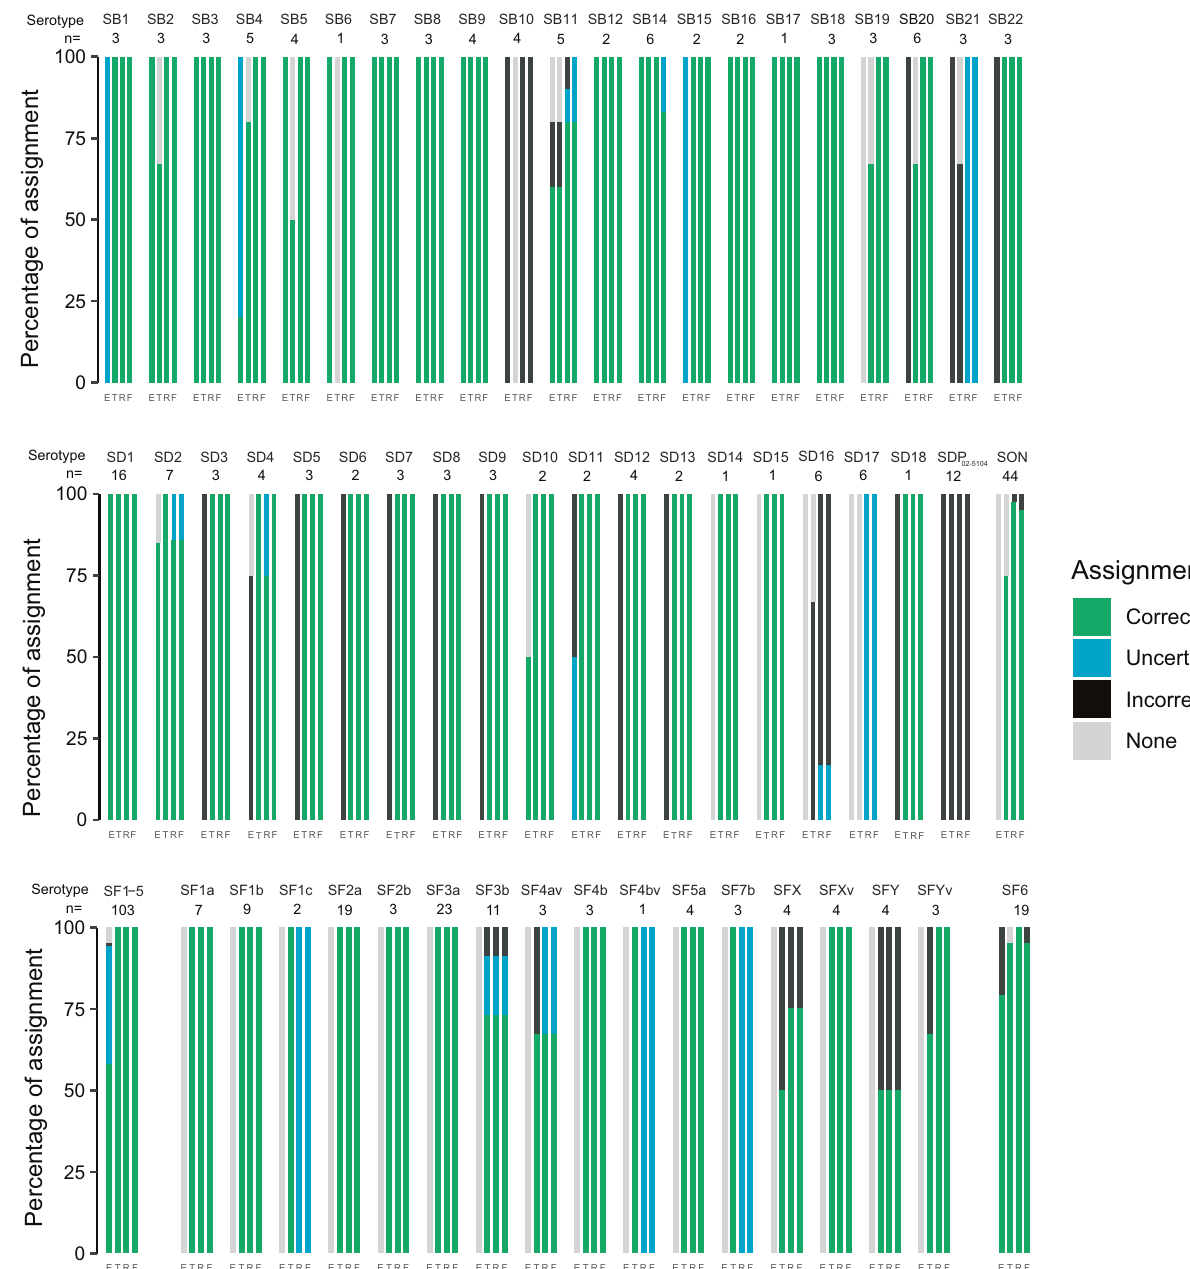
Fig. 8 Graphical representation of the in silico serotyping results for 316 Shigella reference strains according to each serotype prediction tool. Stacked- bar chart displaying the results (percentage assignment) per tool for each Shigella serotype. E, the SeroPred tool implemented in EnteroBase 18 ; T, ShigaTyper 14 ; R, ShigEiFinder 16 using short reads; F, ShigEiFinder using SPAdes assemblies. SB S. boydii , SD S. dysenteriae , SON S. sonnei , SF S. fl exneri . A correct assignment means that the predicted serotype was the same as the phenotypically determined serotype. An uncertain assignment means that the correct serotype was listed among others or, for ShigEiFinder that only the cluster level (Cs1 to Cs3) was obtained. An incorrect assignment means that the predicted serotype was different from the phenotypically determined serotype. “ None ” means that no serotype was predicted. More detailed results can be found in Supplementary Table